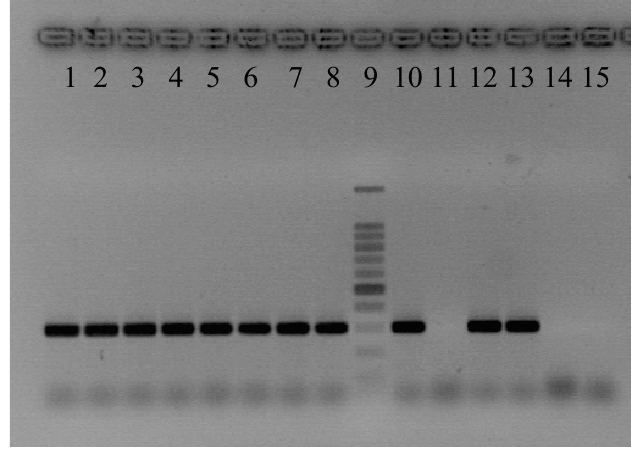
Figure 8. The species specific identification of the E. durans strains by PCR